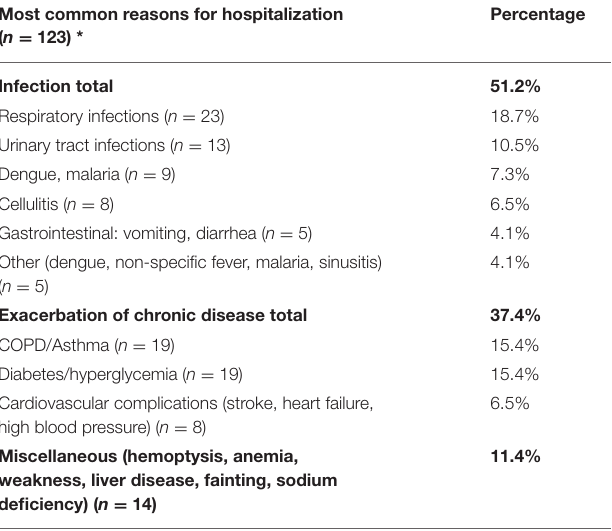
TABLE 3 | Most common reasons for